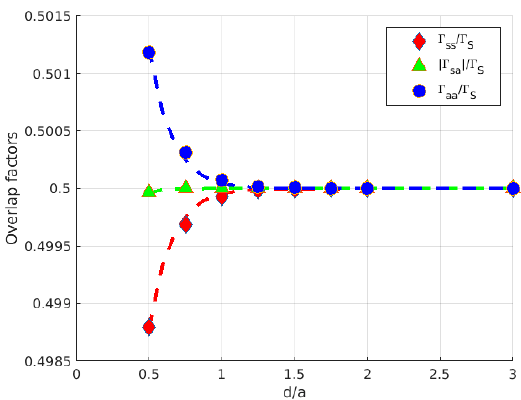
Figure 5. Overlap factors versus d / a for coupled circular cylindrical guides with v = 3.740.